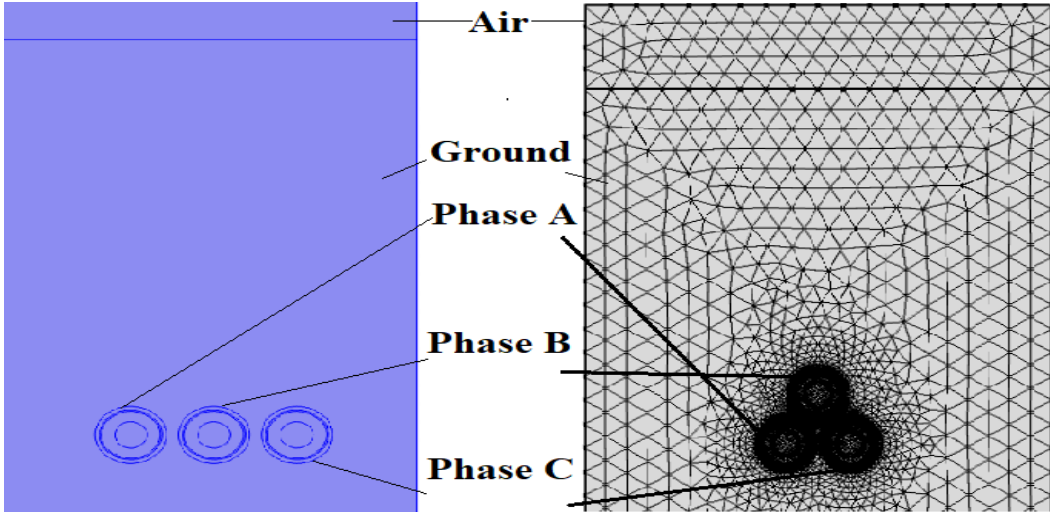
Figure 2. View of the model calculation range and a fragment of the applied mesh in the field of laying cable lines in the ground for two work systems in